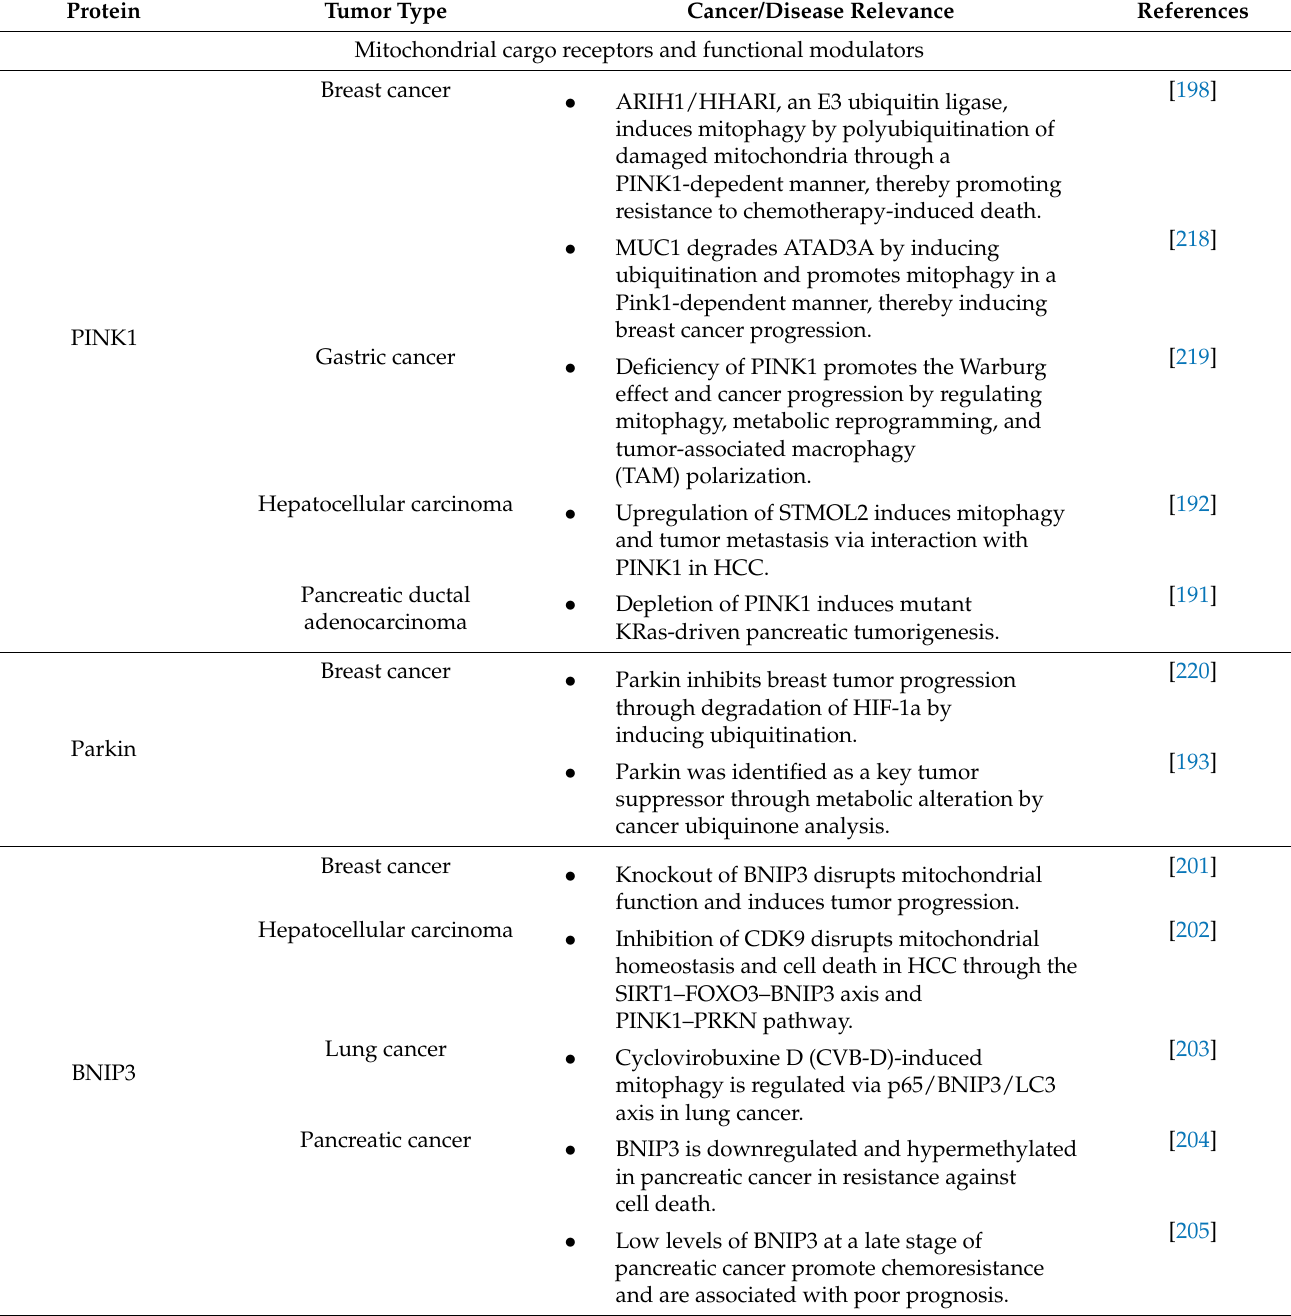
Table 4. Role of mitophagy in